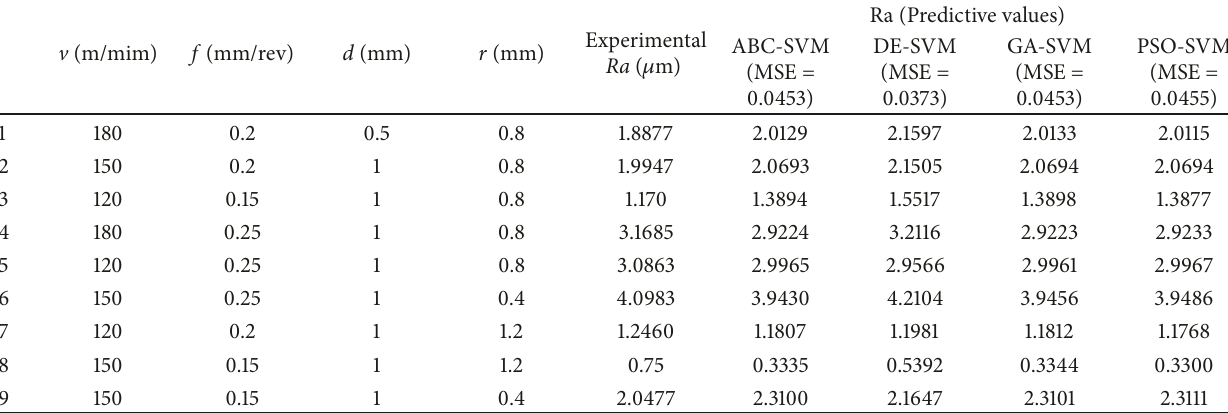
Table 10: Testing results for Ra of AISI 1045 steel at minimizing MSE.